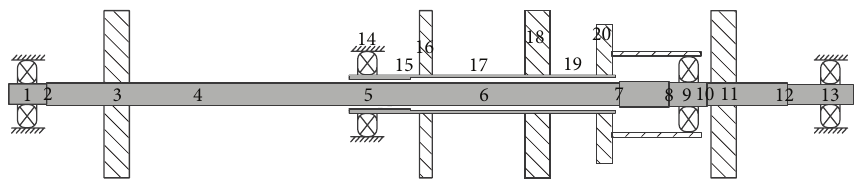
Figure 2: The node map of one dimensional finite element model of dual-rotor system.